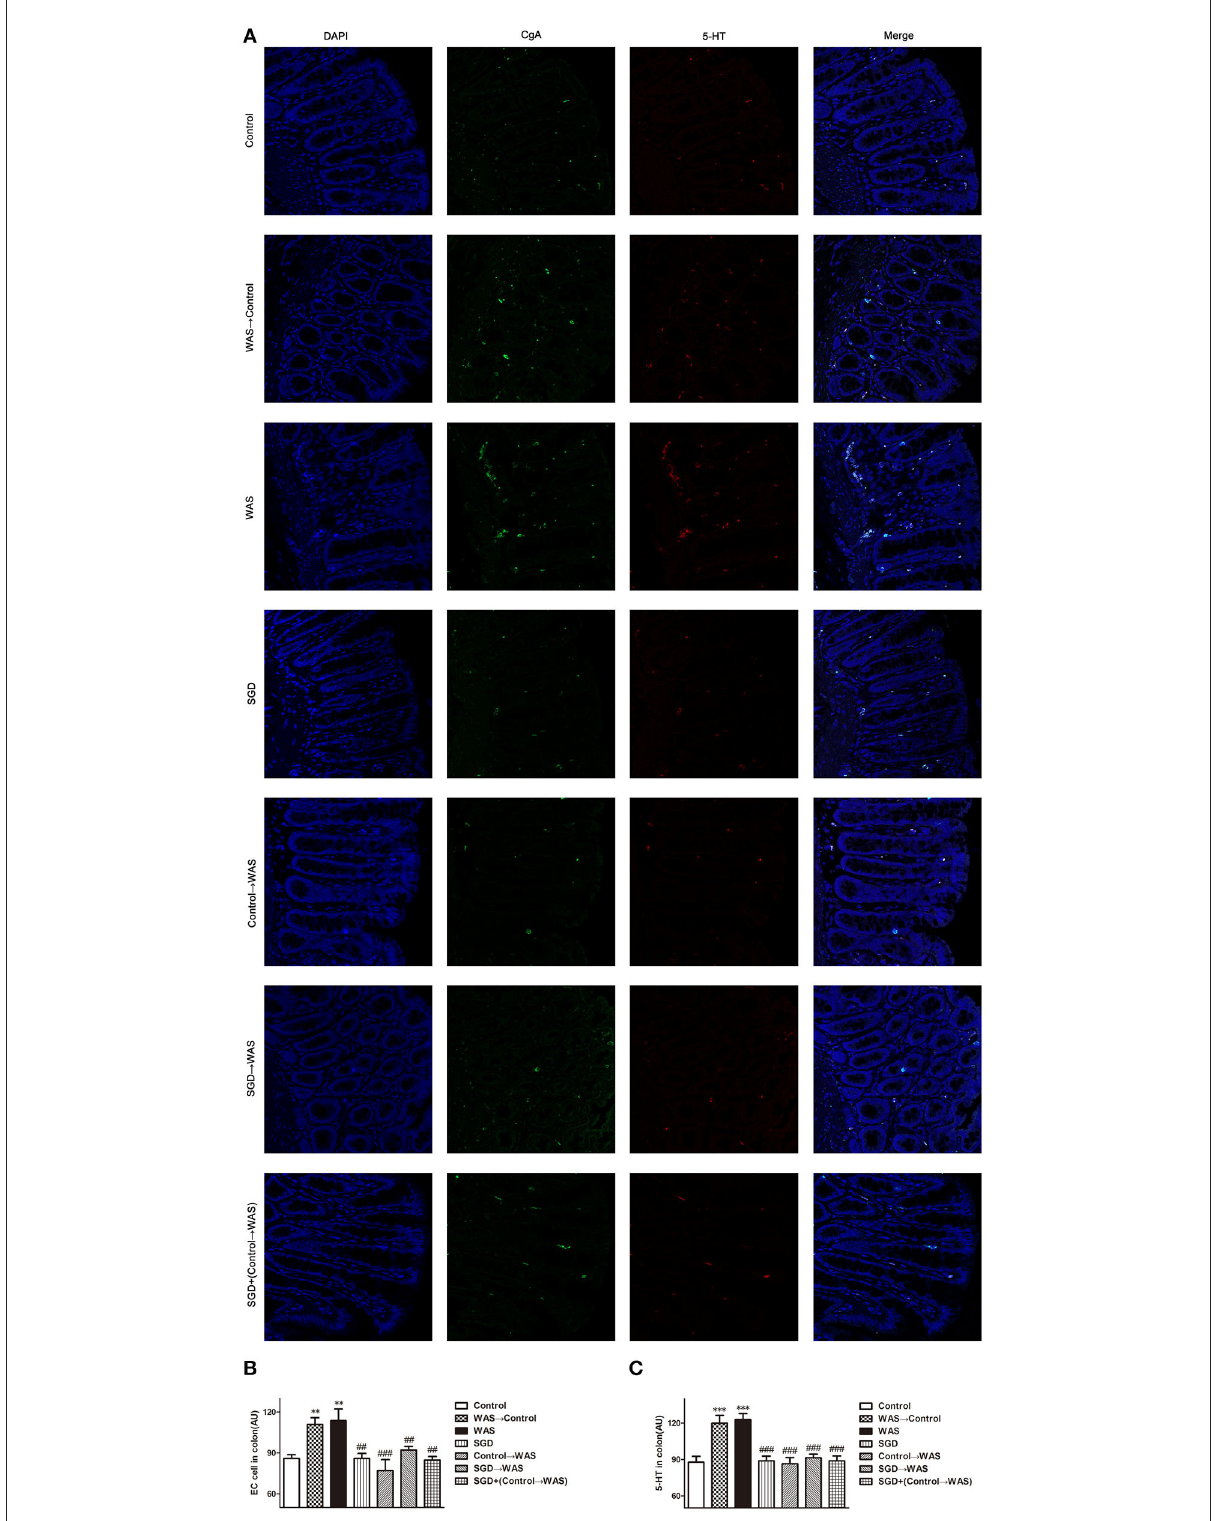
FIGURE5 Effects of several FMT combined with or without SGD on ECs numbers and 5-HT content in the colon of rats. (A) Colon immunofluorescence staining in rats. (B) Statistical plot of ECs numbers in the colon. (C) Statistical plot of the 5-HT content in the colon (All results are expressed as mean ± SE n = 5/group, ** P < 0.01 vs. Control, *** P < 0.001 vs. Control, ## P < 0.01 vs. WAS, ### P < 0.001 vs.